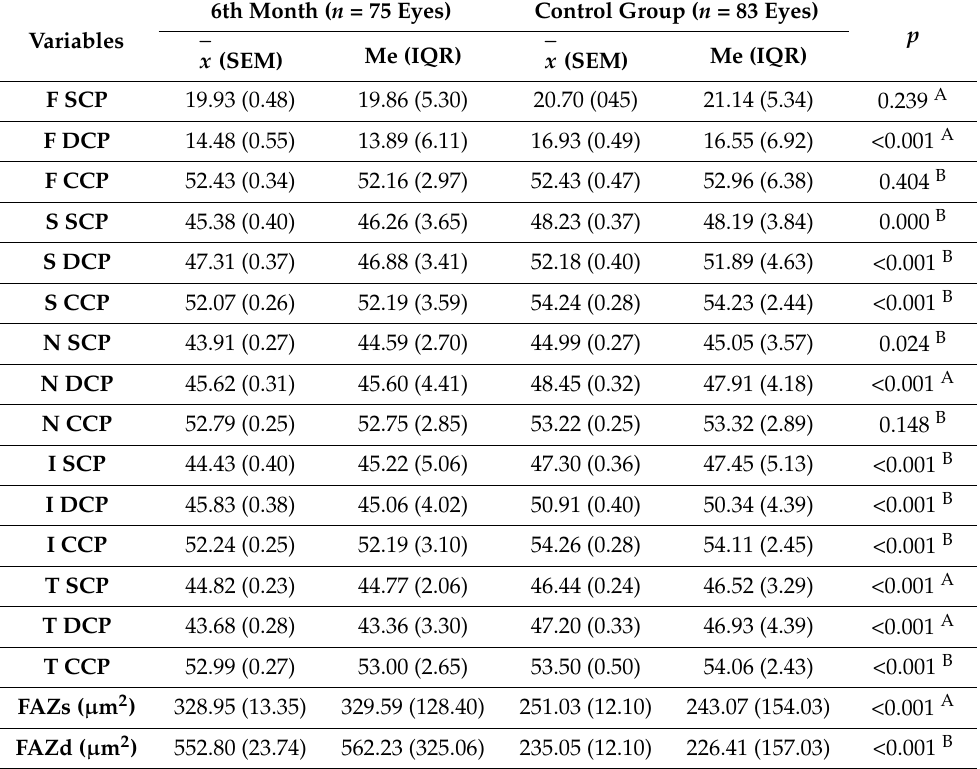
Table 2. Comparison of foveal (F) and parafoveal parameters of OCTA (optical coherence tomography angiography) between COVID-19 patients (women and men) in the 6-month and control group: SCP— superficial capillary plexus, DCP—deep capillary plexus, CC—choriocapillaris, FAZ s—superficial foveal avascular zone, FAZ d—deep foveal avascular zone, F—foveal area, S—superior area, N—nasal area, I—inferior area, T—temporal area. Mean ± SEM (standard error of the mean) structural OCT values. Bold values denote statistical significance at the p < 0.05